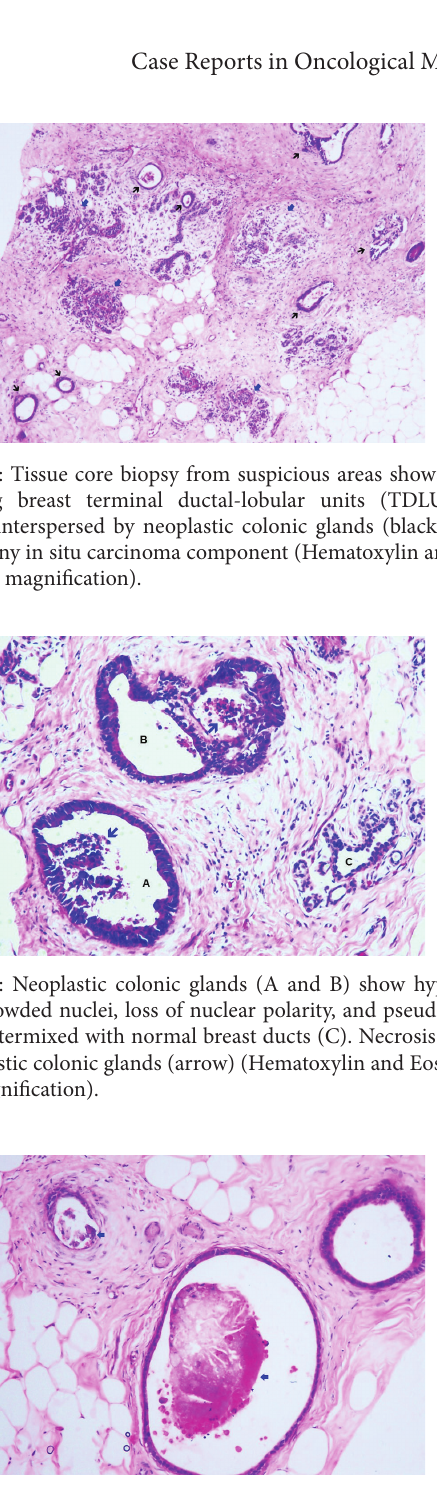
Figure 6: Metastatic colonic glands show intraglandular microcal- cifications (arrow) (Hematoxylin and Eosin stain, 200x magnifica-